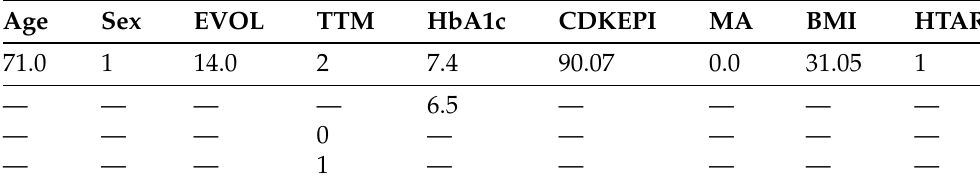
Table 1. Patient example and counterfactual